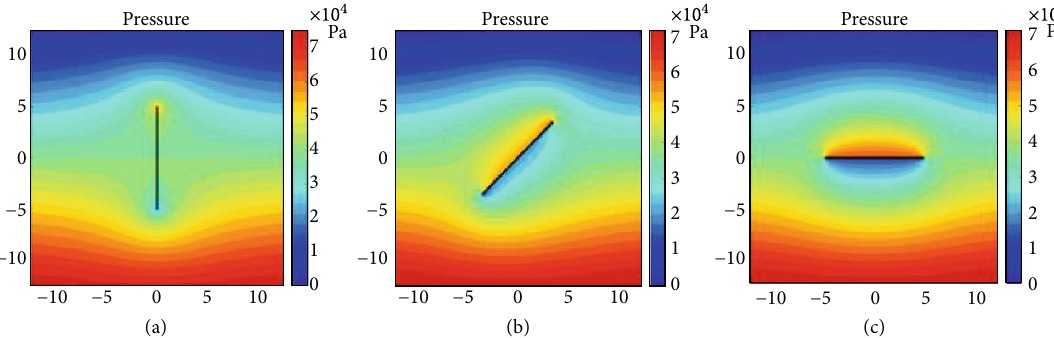
Figure 8: Pressure contours (in Pa) for fractures with the same properties as Case A (Figure 7(a)) but with doubled e ff ective fracture strength of 4 : 76 × 10 − 6 m 4 /s .